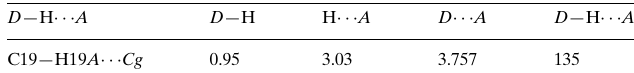
Hydrogen-bond geometry (A˚ , (cid:2) ). Cg is the centroid of the C7–C12